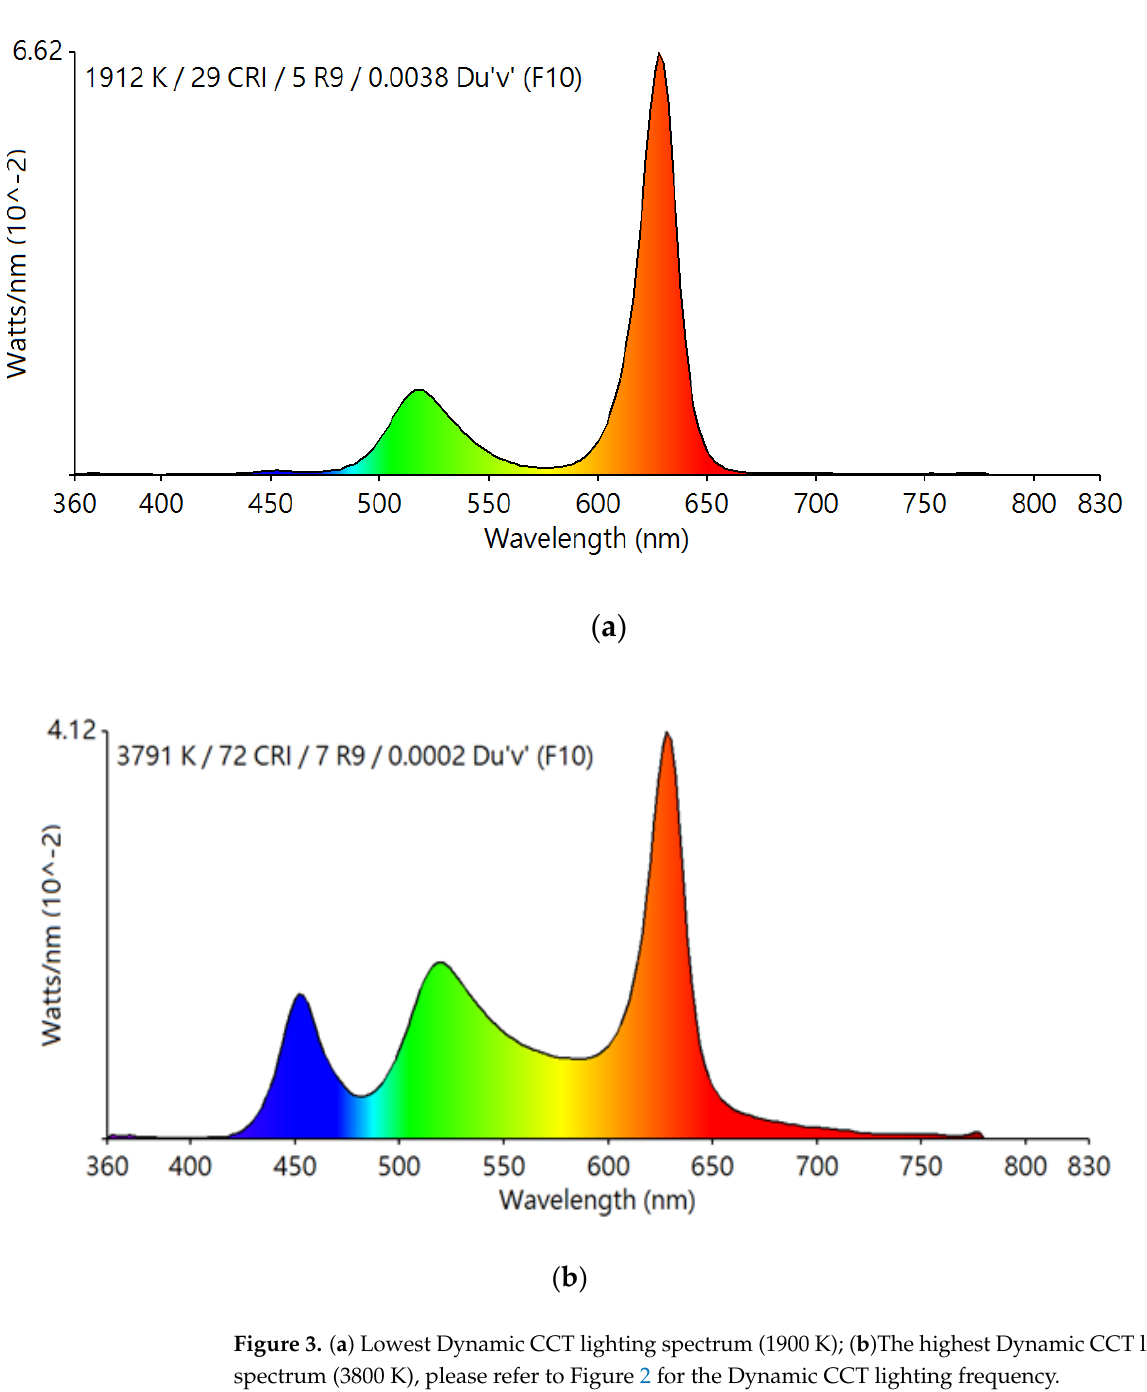
Figure 4. Dim light spectrum, which is the same as the lowest Dynamic CCT lighting spectrum (1900 K), is designed according to the night light spectrum. 2.2. Experimental Limits and Regulations